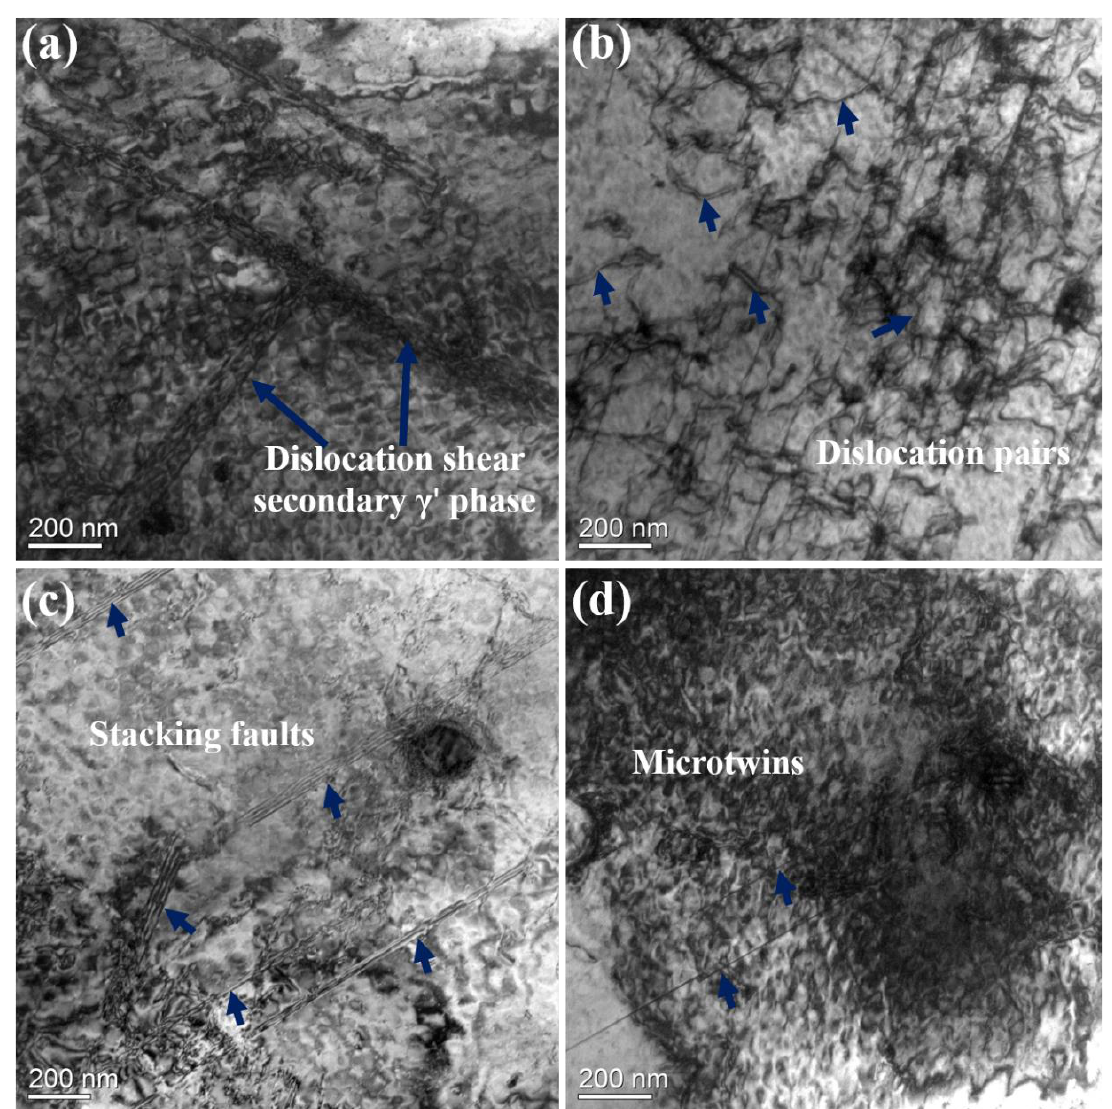
Figure 15. Deformed microstructure in the fractured specimen of 35Co: ( a ) dislocations that sheared secondary γ′ precipitates ; ( b ) dislocation pairs within γ′ precipitates ; ( c ) high-density stacking faults; ( d ) microtwins that cut through γ′ precipitates.